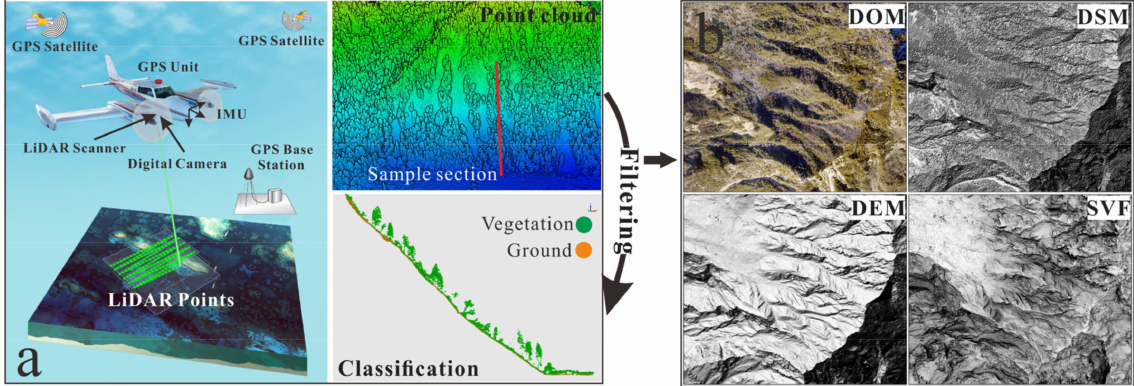
Figure 3. Processing flow and products of airborne LiDAR data. ( a ) LiDAR pointcloud acquisition and processing; ( b ) LiDAR products and topographic